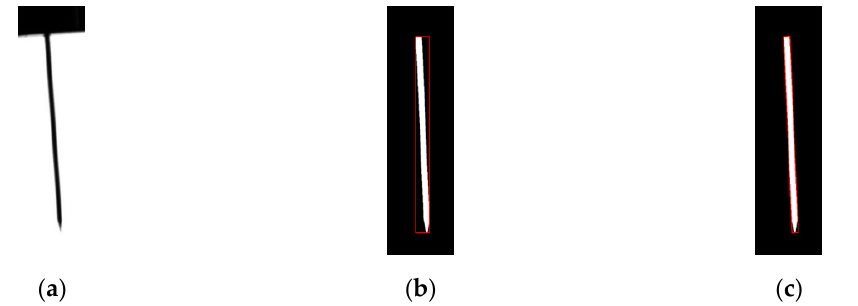
Figure 11. Detection of rotated cutting blade. ( a ) Acquired image; ( b ) generalized bounding box used for image detection; ( c ) minimum rotated rectangle bounding box for image detection.